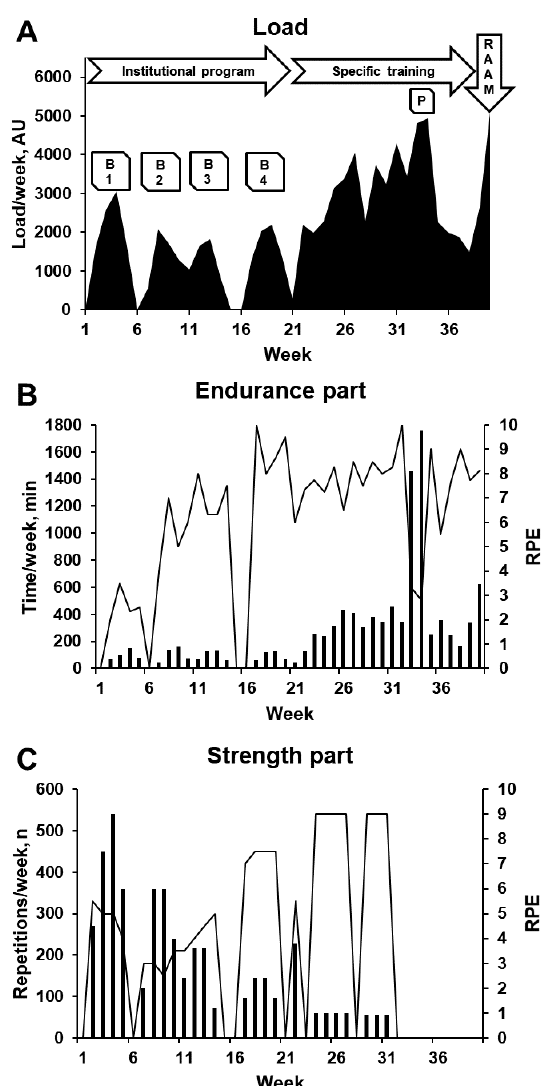
Figure 2. ( A ) Load of each week (the sum of loads of each workout of the week) during the four blocks (B1–B4) of the institutional physical activity program for physically inactive students, the cycling specific training program (with the pilgrimage of eight days (P)), and the Race Across America (RAAM). ( B ) Volume (total time per week) and intensity (mean rating of perceived exertion (RPE) per week) of endurance parts. ( C ) Volume (total number of repetitions per week) and intensity (mean RPE per week) of strength parts.